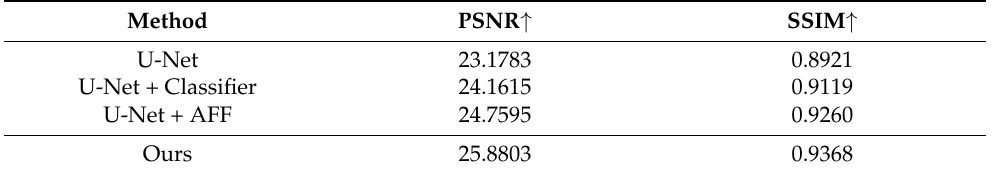
Figure 6. Visualization comparison of our colorization algorithm and other colorization algorithms. Our colorization network generates more vivid and saturated colorful images. Table 3. Ablation experiments. The PSNR and SSIM values show that the classification subnetwork and the AFF module play a positive role in the colorization effect of the